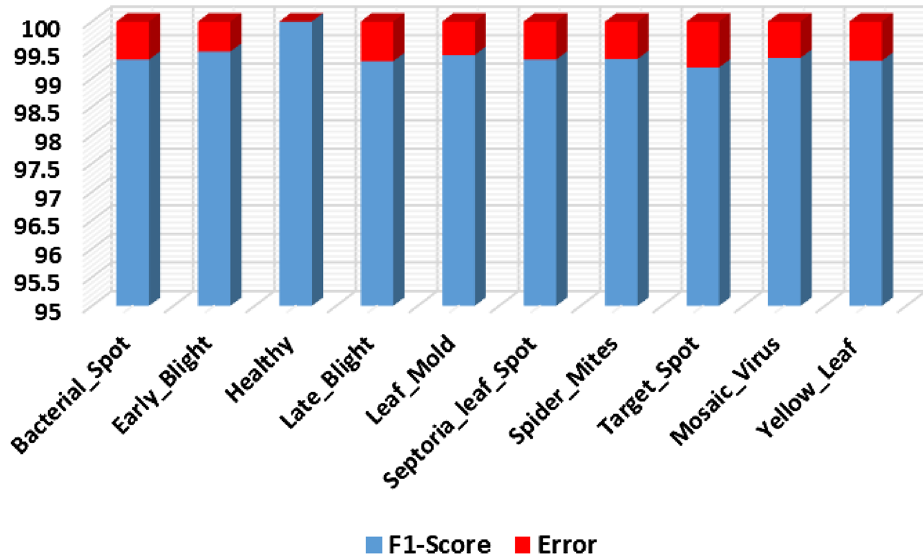
Figure 10. Evaluation using F1 score and error rate.